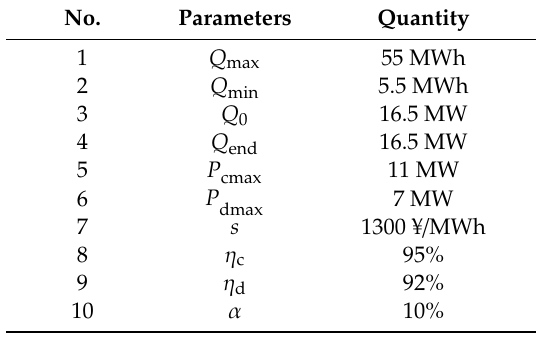
Table 1. Parameters of the BSS.